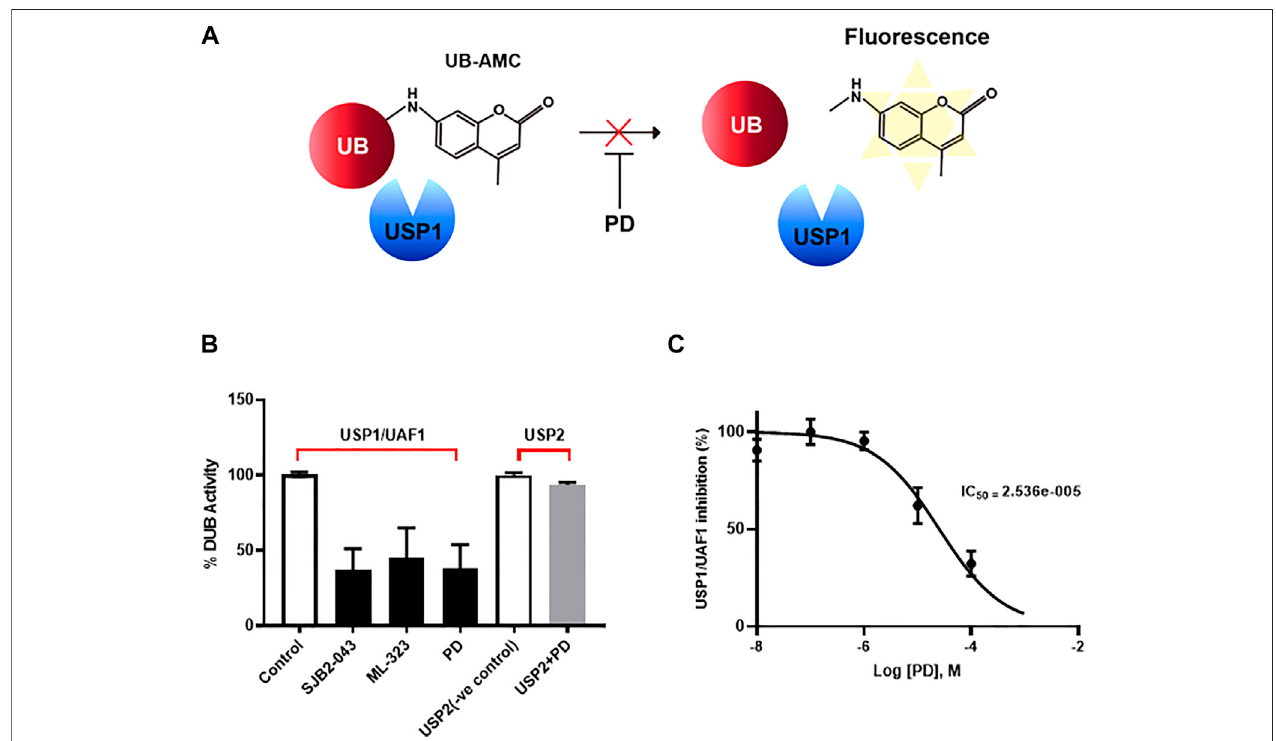
FIGURE4| PDspeci fi cally inhibited USP/UAF1 activity. (A) Schematic representation ofUb-AMCassay.USP1 removes ubiquitin fromits substrateUb-AMC,and fl uorescentAMCismeasured. (B) rUSP1/UAF1complexorrUSP2wereincubatedwithcontrol,USP1inhibitorSJB2-043,ML-323,orPDfor30 minat37 ° C,followedby assessment of DUB activity using Ub-AMC assay. (C) Progress curve for USP1/UAF1 activity on PD against Ub-AMC. The graph represents the average of three independent experiments with calculated SEM. The experiment was conducted at least four times.